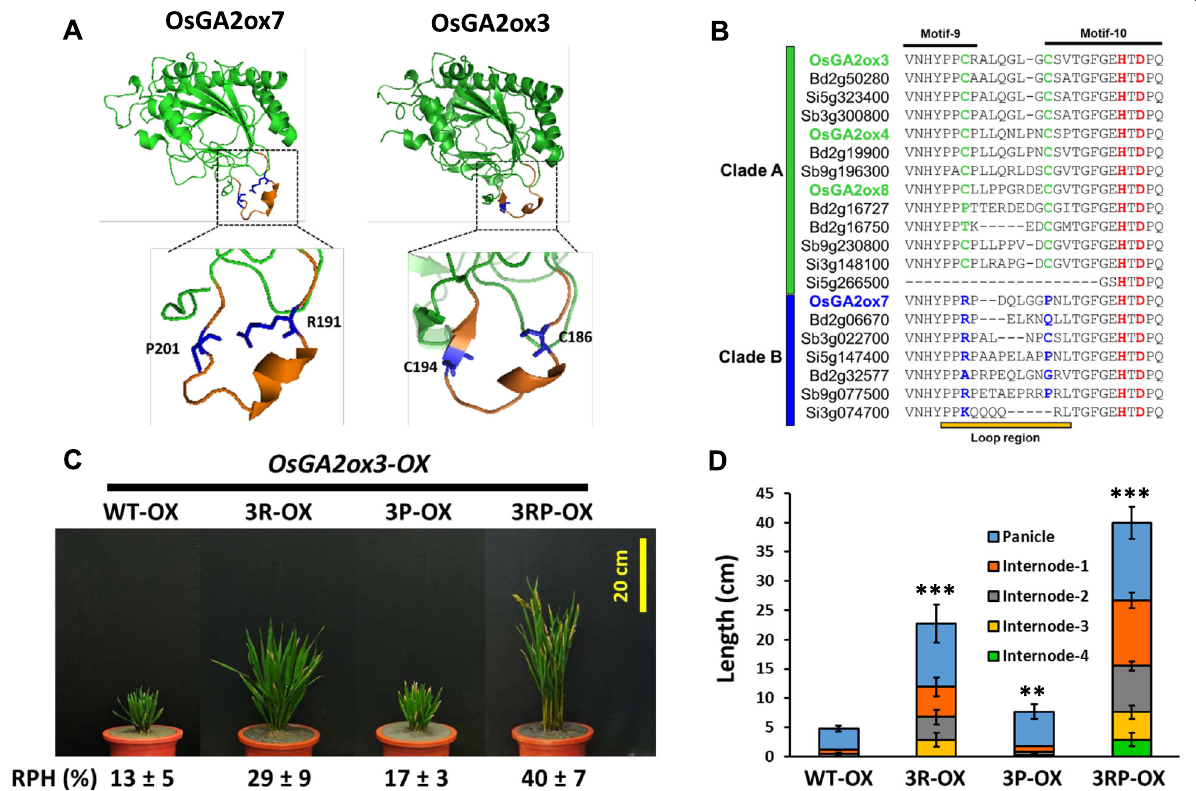
Fig. 8 Comparisons of OsGA2ox7 and OsGA2ox3 3-D protein structures and sequence alignment to show the conserved amino acids between clades A and B and the phenotypes of WT-OX, 3R-OX, 3P-OX and 3RP-OX transgenic rice plants . a Simulated protein structure of OsGA2ox7 and published protein structure of OsGA2ox3 for comparison. The loop regions contain clade A-specific C186 and C194, and their corresponding amino acids R191 and P201 in OsGA2ox7 show different structures. The 3-D protein structures were visualized by using PyMOL (Schrodinger 2015). b Detailed consensus amino acid sequence alignment of the loop region between motif 9 and motif 10 distinguished by two conserved Cs (highlighted with green color) in clade A from other variants (highlighted with blue color) in clade B. c Phenotypic comparison of WT-OX, 3R- OX, 3P-OX and 3RP-OX transgenic rice plants. A representative overexpression T 0 transgenic plant with the average RPH from each overexpression line is shown. Values are means ± SE ( n = 5). d Statistical comparisons of the length of the main culms (including panicles and internodes) from each overexpression line. Values are means ± SE ( n = 5). The significant differences using Student ’ s t -test are indicated